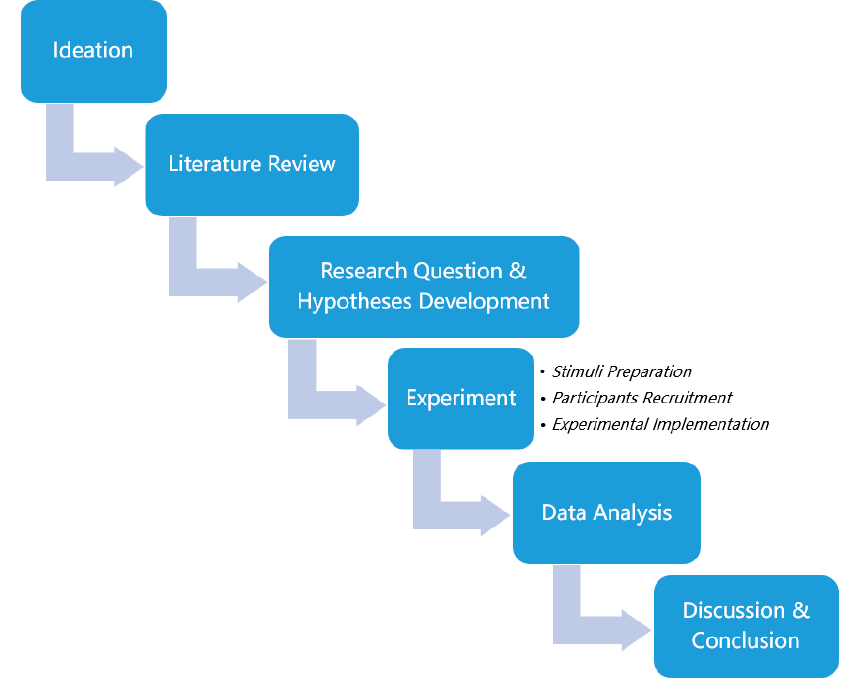
Figure 1. The Research Flowchart.